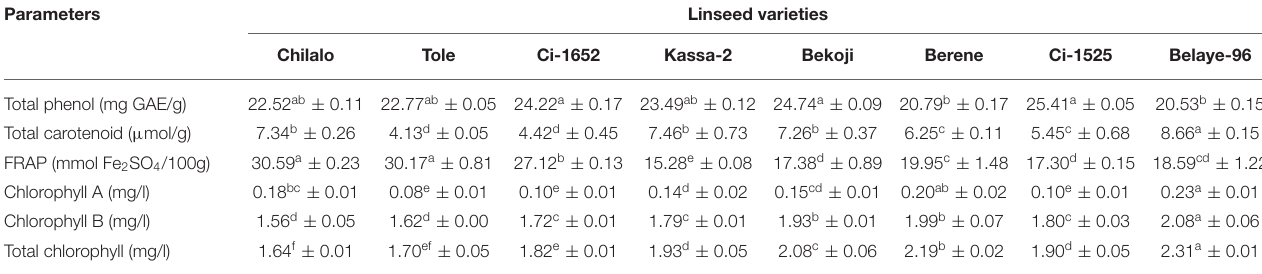
TABLE 4 | Total antioxidant contents and properties of the linseed varieties.